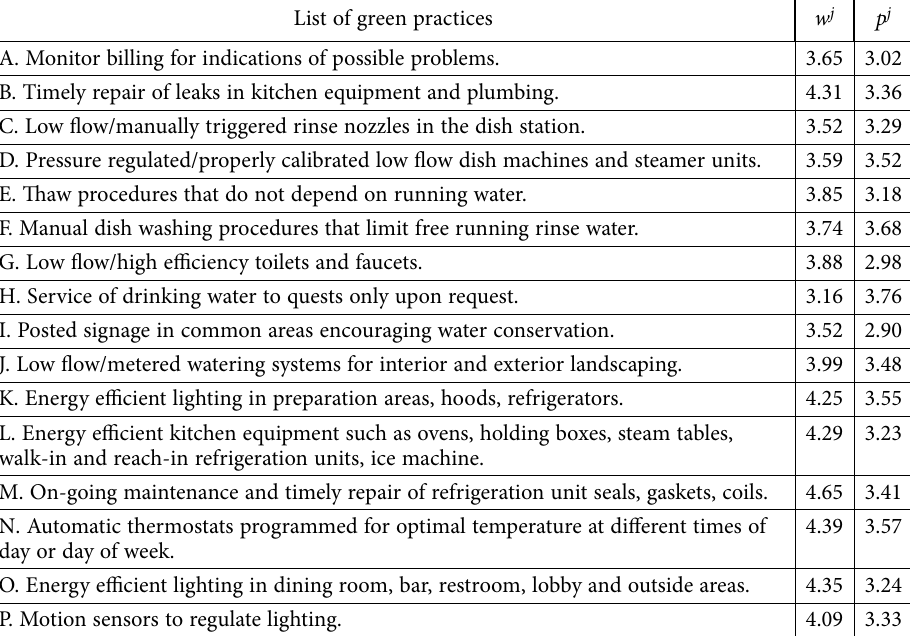
Table 2. Importance and performance of green practices (source: Lee et al., 2020) List of green practices w j p